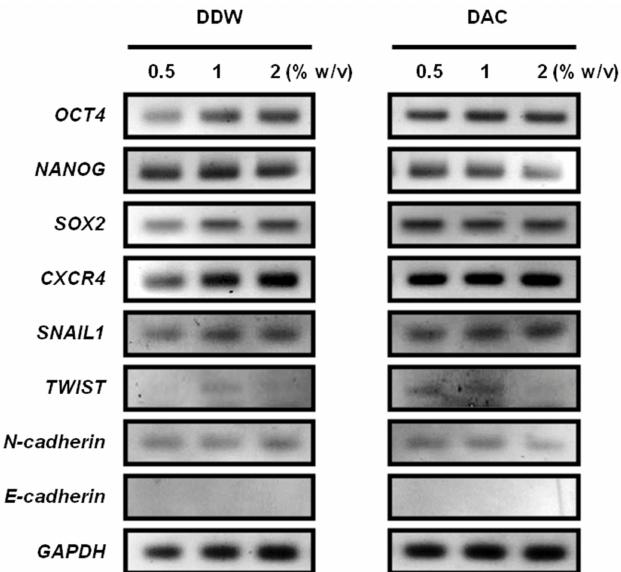
Figure 12. Characterization of adipose-derived stem cells on porous scaffolds by reverse transcriptase polymerase chain reaction analysis. Expressions of pluripotency markers ( OCT4 , NANOG and SOX2 ), mesenchymal stem cell marker ( CXCR4 ) and epithelial-mesenchymal transition markers ( SNAIL , TWIST , N-cadherin , and E-cadherin ) were determined at day 10 after